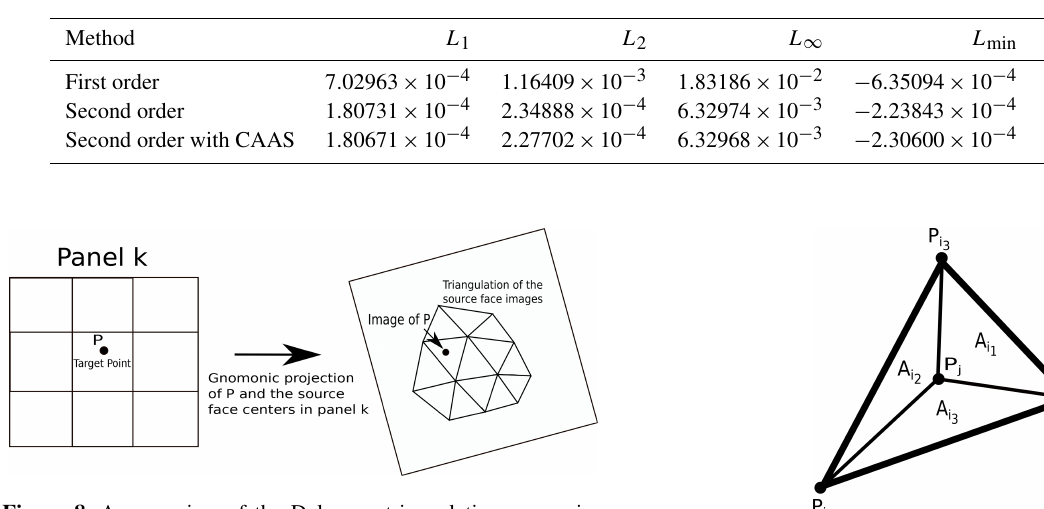
Table 2. Error norms for remapping from an ne360 cubed sphere to a 0.25 ◦ latitude–longitude mesh.